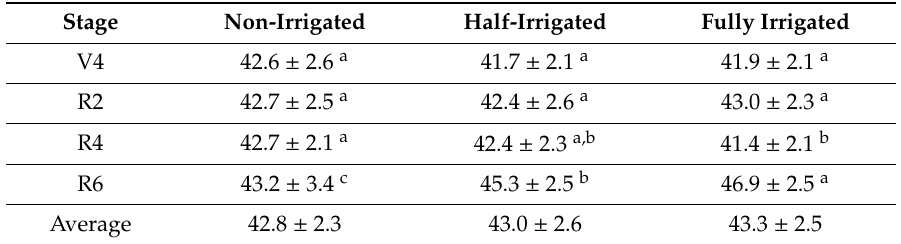
Table 3. The e ff ect of di ff erent irrigation regimes on SPAD at di ff erent stages of soybean’s (cv. Pannonia Kincse) life cycle, averaged among 2017, 2018, and 2019 in Debrecen, Hungary.